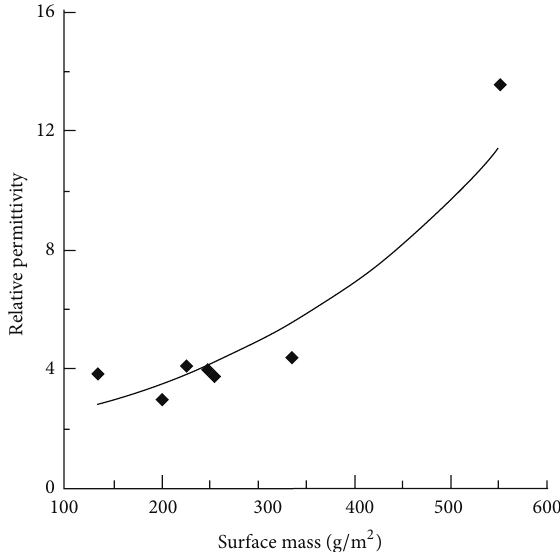
Figure11:Constantlevelcurvesoftherelativeelectricalpermittivity of weaves from natural cellulosic fibres as a function of the threads per 1dm in direction of warp and in direction of weft. 3D contour plot (NEW.STA 10v ∗ 22 c) 𝑧 = 2.6156 −0.0715⋅𝑥 + 0.1591⋅𝑦 + 0.001⋅ 𝑥 2 − 0.0018 ⋅ 𝑥 ⋅ 𝑦 + 0.0003 ⋅ 𝑦 2